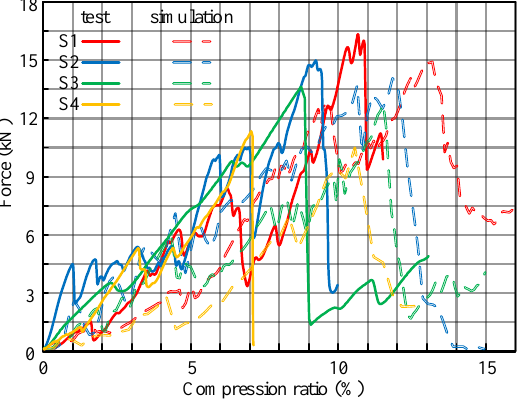
Figure 12. The force-displacement curves for the four performed single-particle breakage tests.